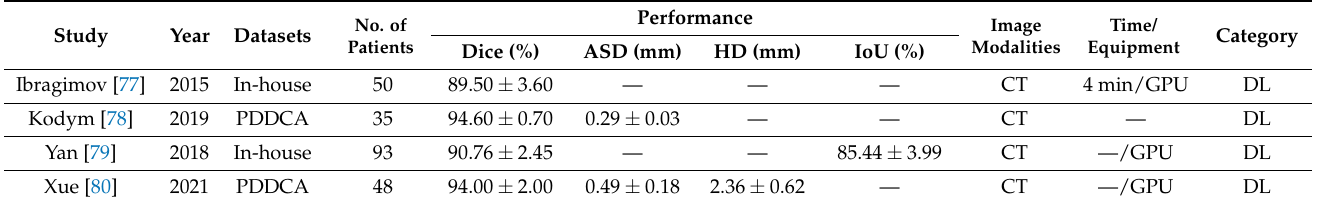
Table 7. Summary of deep learning-based